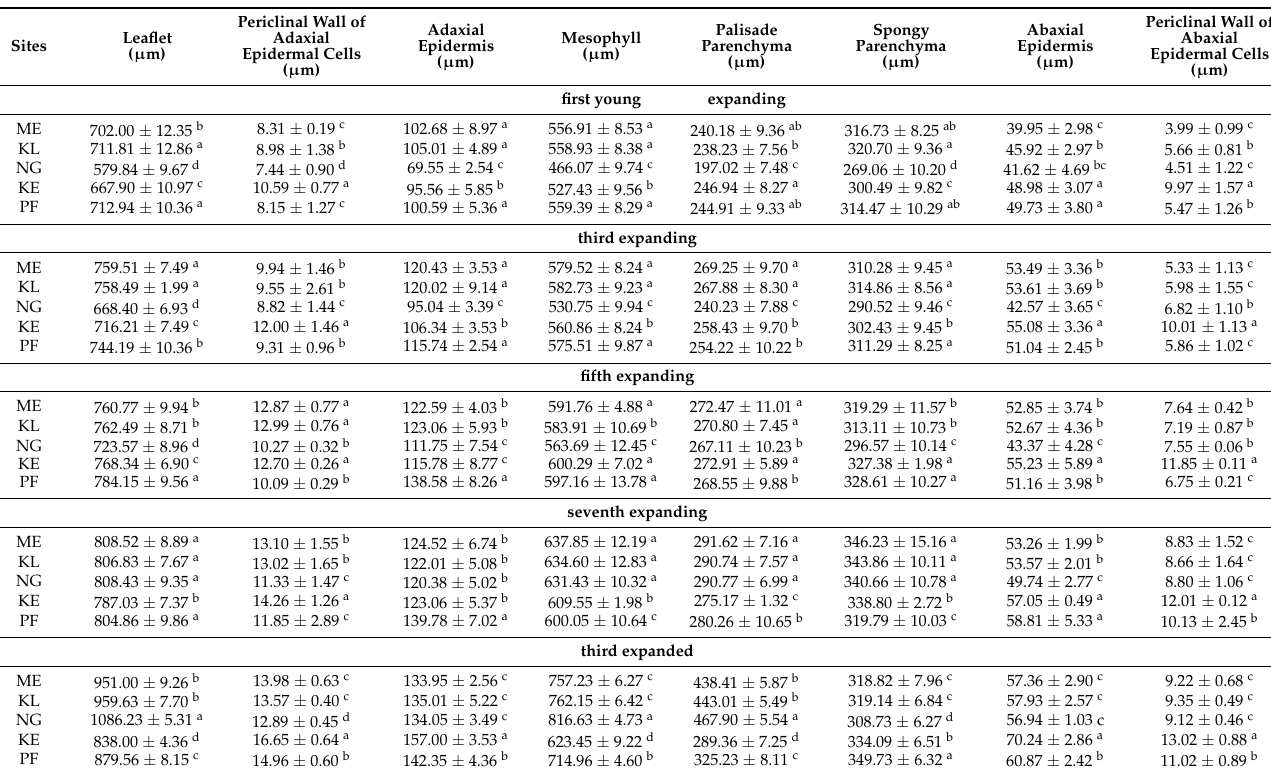
Table 2. Thickness of morphological traits of expanding and expanded leaflets of the compound leaves of C. siliqua . The values are means of 30 replicates ± standard deviation. Different lower- case, superscript letters next to each value correspond to statistically significant differences of each parameter in each developmental stage of the leaflets between sites (one-way ANOVA, t -test at p < 0.05; for all cases n =